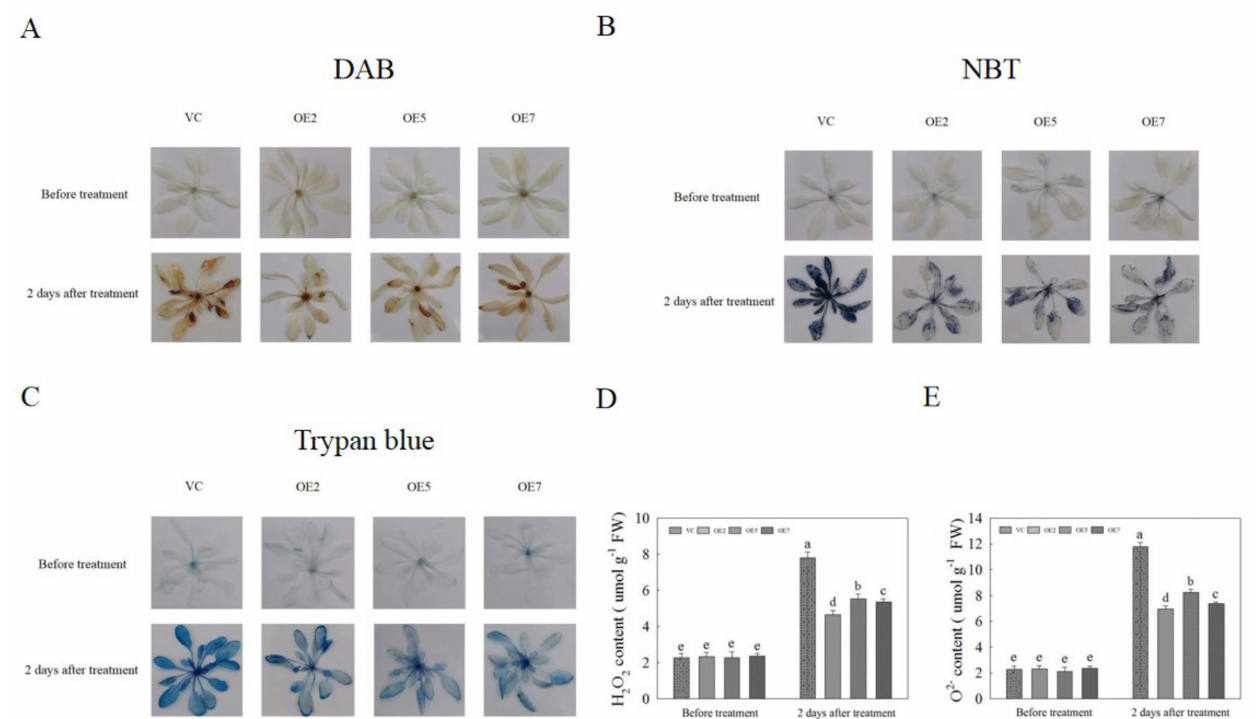
Figure 8. Reactive oxygen species (ROS) scavenging ability and cell death of vector control (VC) and overexpression (OE) Arabidopsis under normal and stress conditions. ( A ) 3,3 (cid:48) -diaminobenzidine (DAB) staining. ( B ) Nitro blue tetrazolium (NBT) staining. ( C ) Trypan blue staining. ( D ) H 2 O 2 content. ( E ) O 2 − content. Different letters represent significant difgerences ( p <